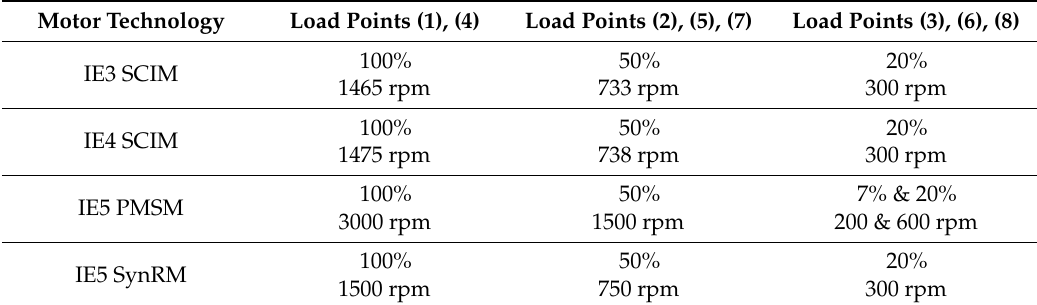
Table 2. Considered motor speed for the eight load points.